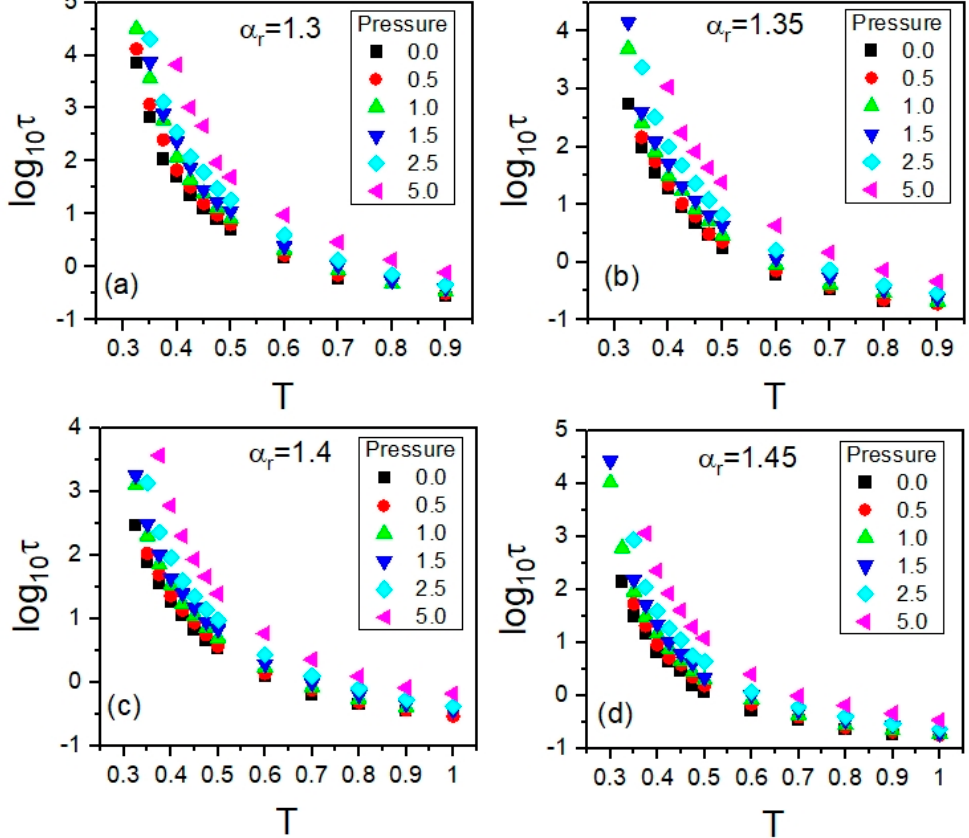
Figure 3. Plots of the isobaric dependences of translational relaxation times τ on temperature T in the supercooled liquid state in the GB model, which are presented in the panels for the different anisotropy aspect ratios α r : ( a ) 1.30, ( b ) 1.35, ( c ) 1.40, and ( d ) 1.45, respectively.